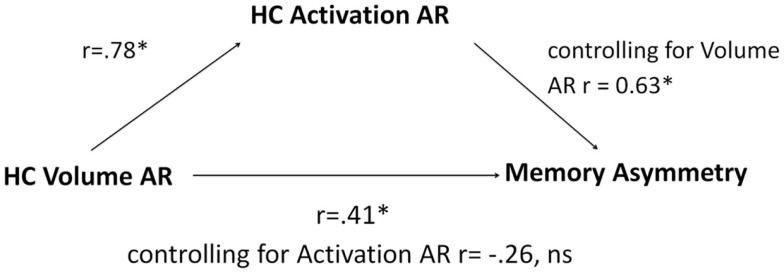
A schematic depiction of the directional flow among the elements of the mediation model with accompanying correlation and partial correlation coefficients of regression equations. HC, hippocampus; AR, asymmetry; ns, not significant, * denotes significant at p < 0.05.